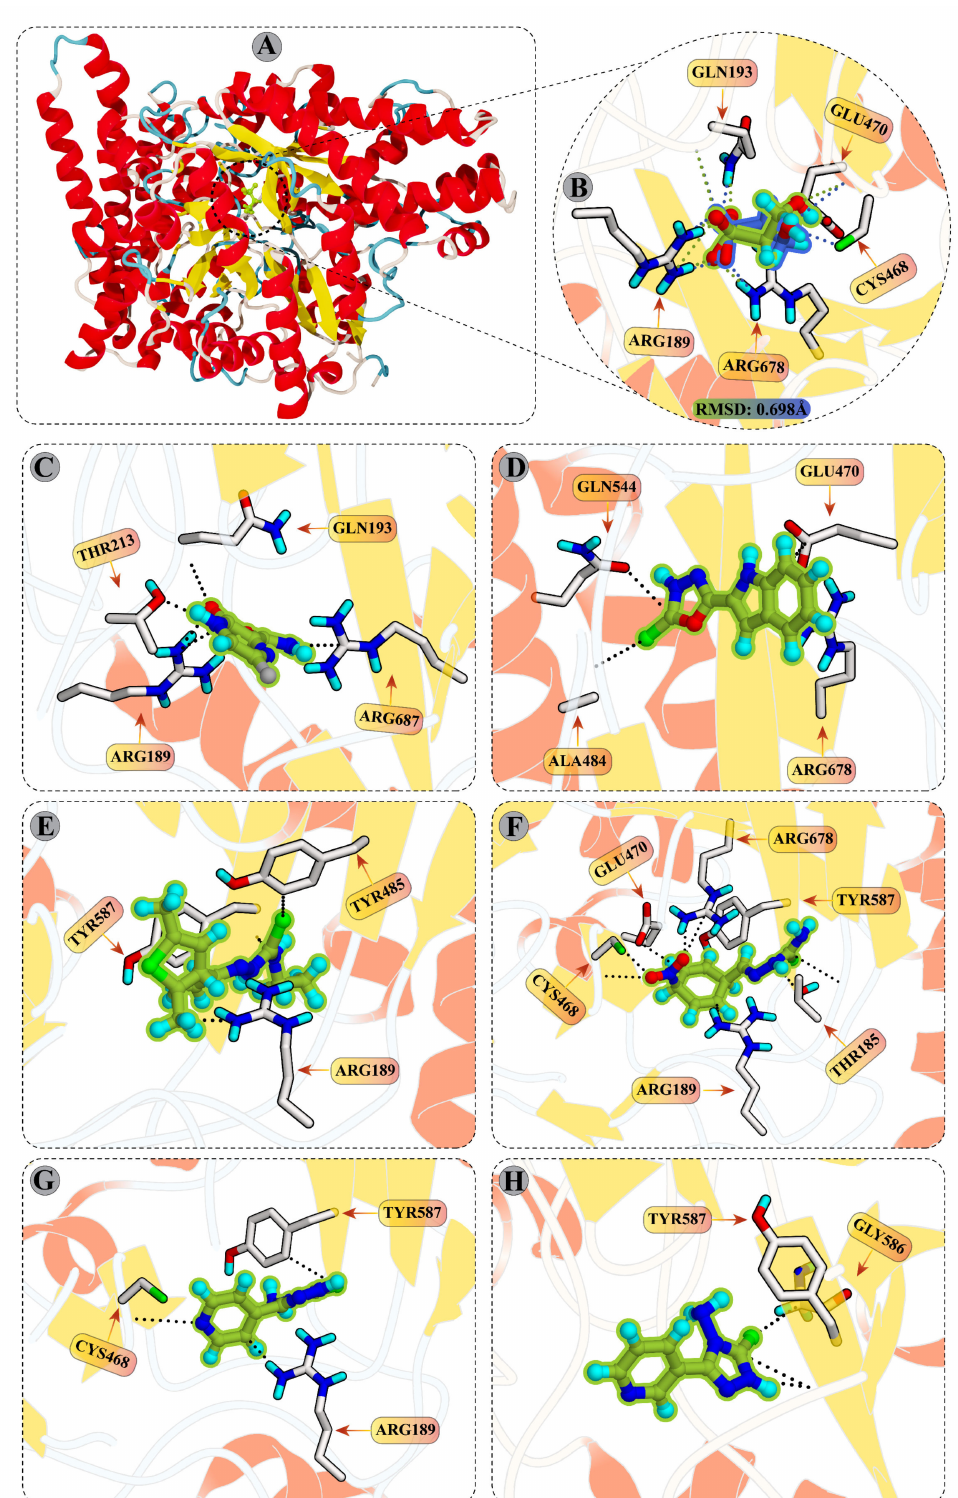
Figure 1. ( A ) The crystal structure of target enzyme, isethionate sulfite-lyase, is shown (PDB ID: 7KQ3); ( B ) the interactions of substrate (2-hydroxyethylsulfonic acid) with the active site residues are highlighted. The interactions of top selected hits from in-house database ( C ) CP1, ( D ) CP2, ( E ) CP4, ( F ) CP5, ( G ) CP8, and ( H ) CP9 with the active site residues are